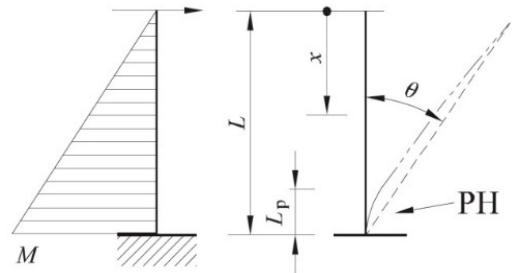
Figure 3. Plastic hinge (PH) of a pier characterized by a cantilever behavior.